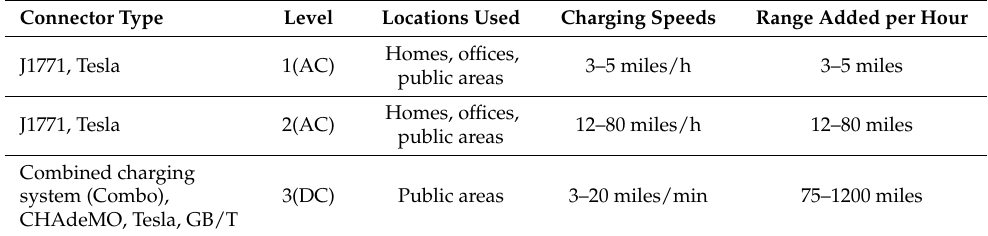
Table 4. AC and DC level connectors and their charging speeds.